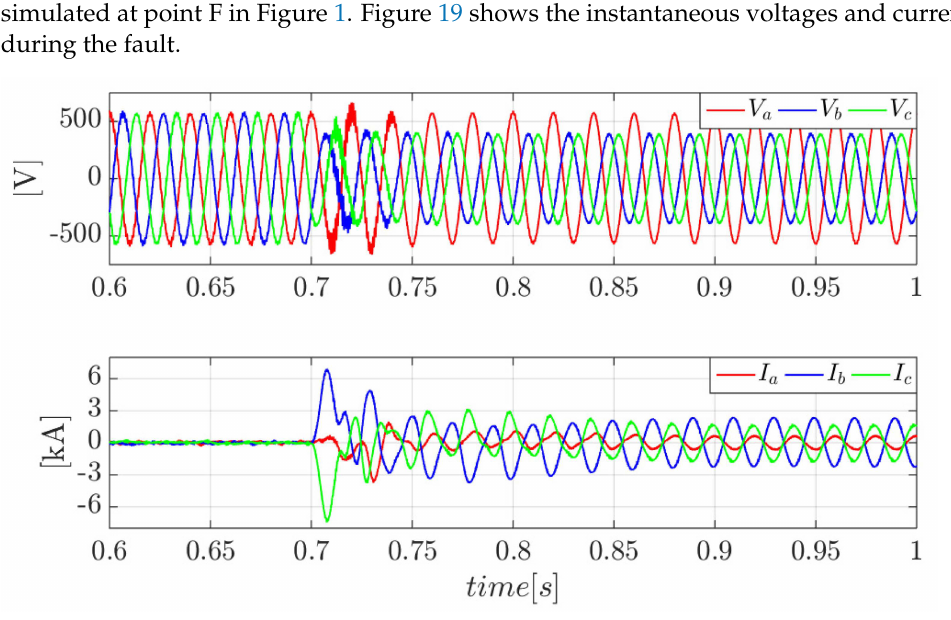
Figure 19. GFM converter instantaneous voltage and currents during an unbalanced fault with 0.23 p.u.